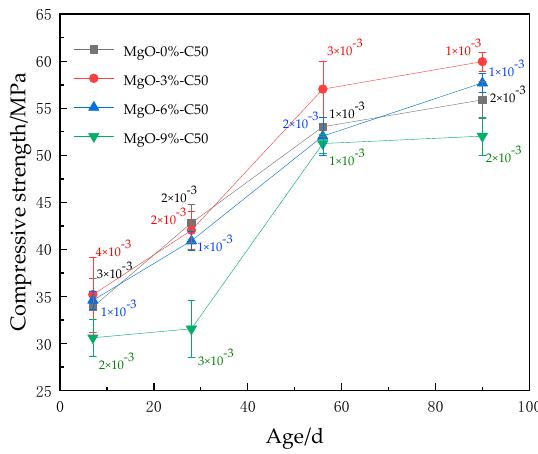
Figure 10. Compressive strength C50 concrete. Figures 11 and 12 show the relationship between the free expansion value rate. Ad- ditionally, the curing time is obtained by measuring the expansion value of concrete at different ages. It is worth noting that magnesium oxide expansion agents have an excellent free expansion rate. With the increase of magnesium oxide content, the free expansion rate of concrete is higher, while the expansion of concrete without magnesium oxide is in a contraction state. Both C30 and C50 concrete show the same trend. For C50 concrete, the free expansion of MgO tends to be stable after 28 days, while the free expansion of C30 concrete tends to be stable after 120 days. Therefore, the expansion of lightly burned magnesia is slightly faster in the early curing stage and tends to be slow in the later curing stage. Compared with the calcium-oxide-based expansion agent, the MgO expansion agent’s expansion rate is lower, and the expansion time is longer [34]. Choi et al. [7] found that magnesium oxide’s hydration was prolonged before 28 days, and hydration accelerated after 28 days. Compared with concrete without magnesia, the 28 days strength of magnesia concrete is lower, but after 90 days, the magnesia expansion agent concrete exhibits higher strength. This is attributed to the fact that the magnesia hydrates more fully, thus decreasing the porosity of concrete leading eventually to the denser structure of